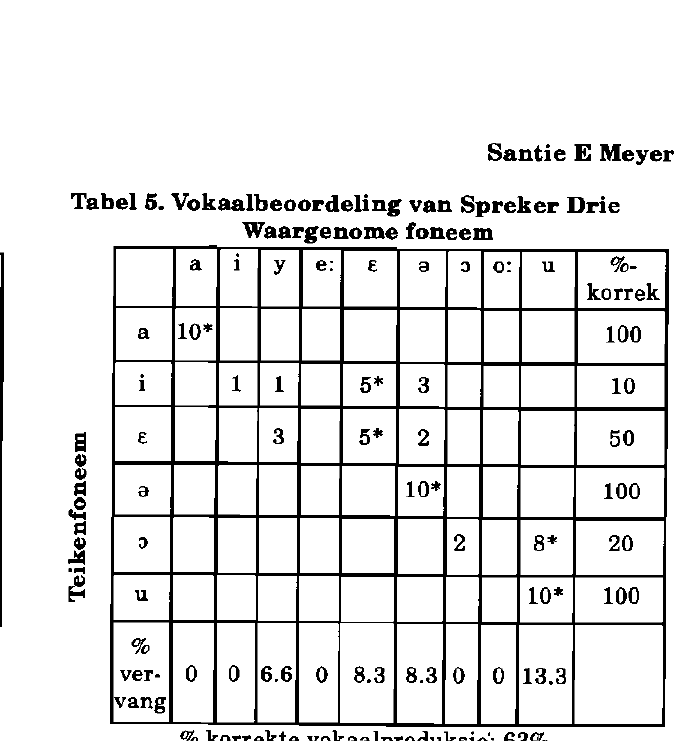
Tabel 3. Vokaalbeoordeling van Spreker Een Waargenome foneem